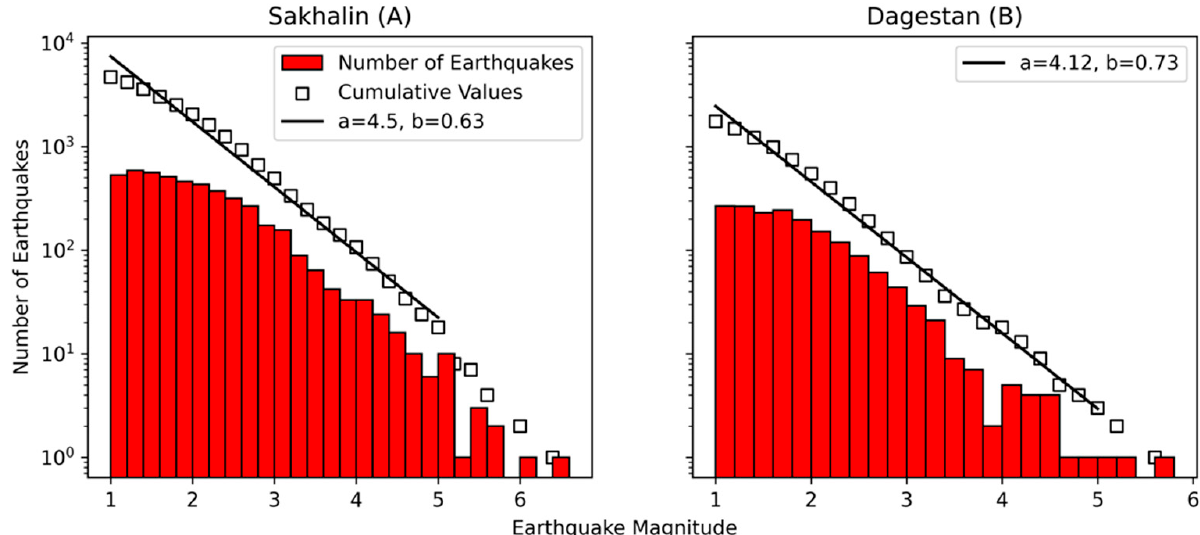
Figure 3. The cumulative Gutenberg–Richter frequency-magnitude distribution of seismic events across Sakhalin (A) and Dagestan (B) datasets, lines are the best fitting values.